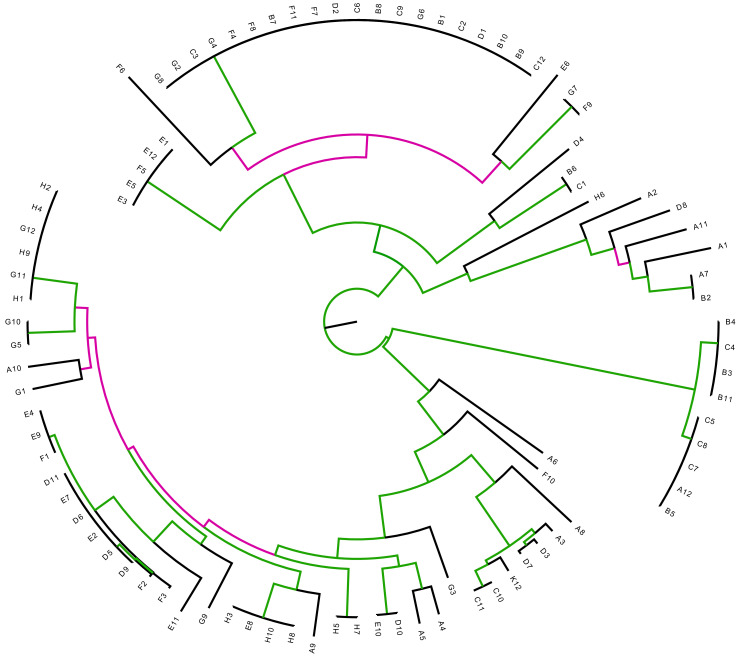
The E.coli core tree is relatively insensitive to removal of all SNPs that correspond to branches of the core tree.Differences between the core tree T and the tree T′ reconstructed from the alignment from which all SNPs that fall on branches of the core tree have been removed. Each branch of the core tree T is colored green when the branch also occurs in T′ and pink if it does not. The Robinson-Foulds distance between two trees is defined as the number of branches (that is bi-partitions) that occur in only one of the two trees. For T and T′ the Robinson-Foulds distance is 62 out of a maximal 178, that is a fraction 0.35 does not match. Note that for tree T′ only 3% of the SNPs fall on its branches.